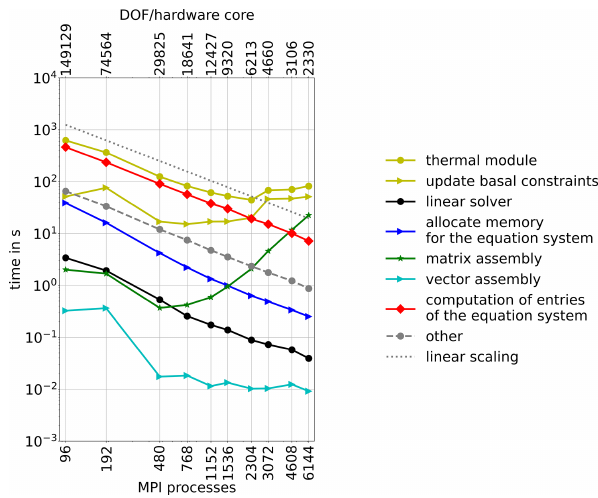
Figure 5. Runtime of the thermal module for